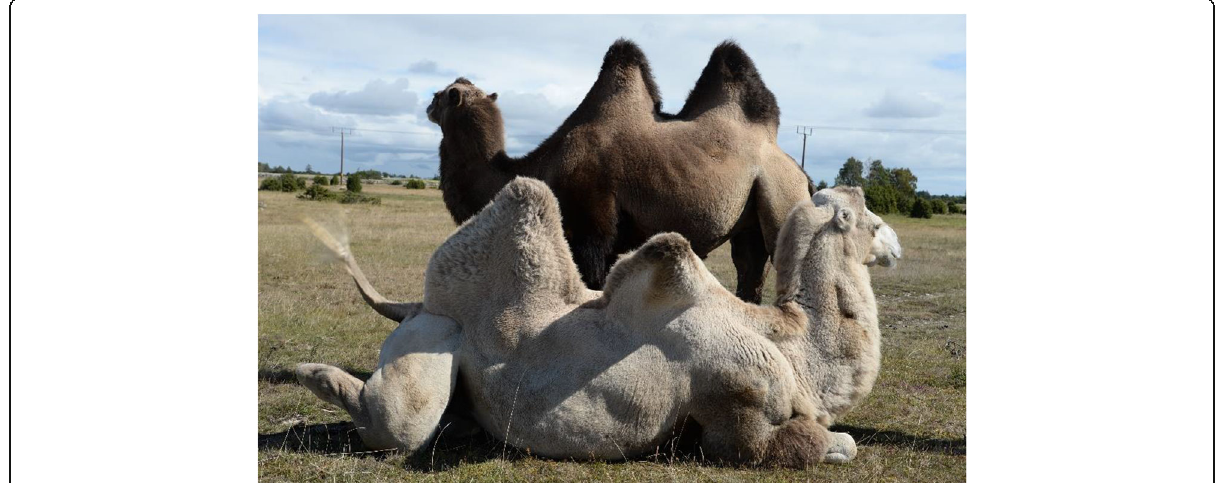
Fig. 18 Bactrian camel farm for tourism attraction, Öland island, Sweden (Ph. B. Faye)